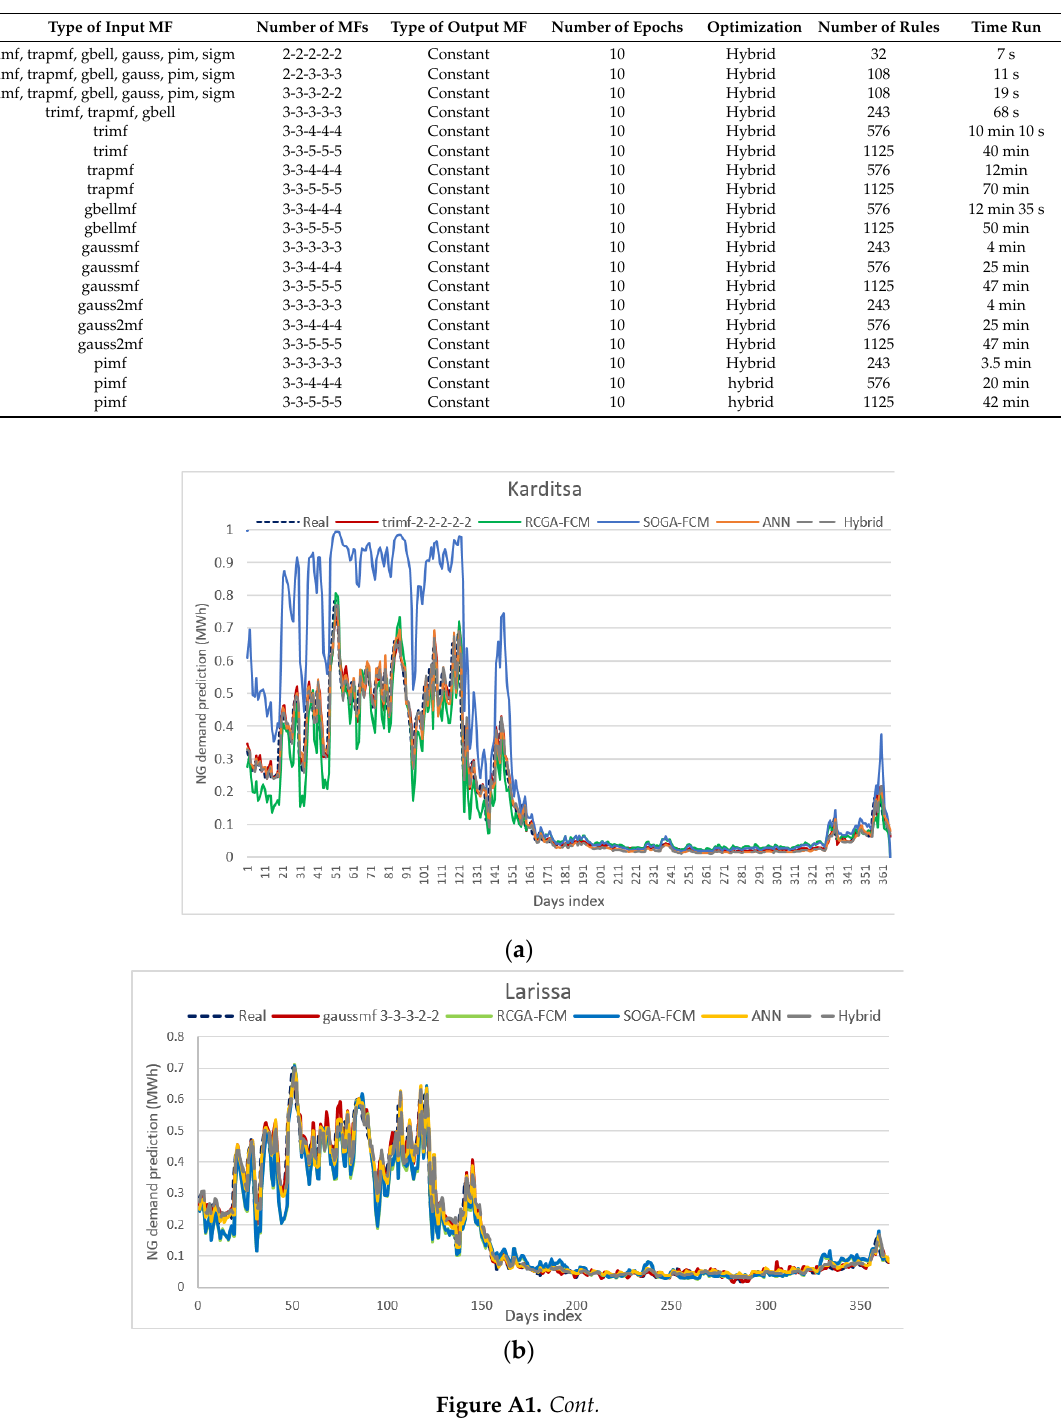
Table A2. Running time and number of rules for all the proposed ANFIS configurations.